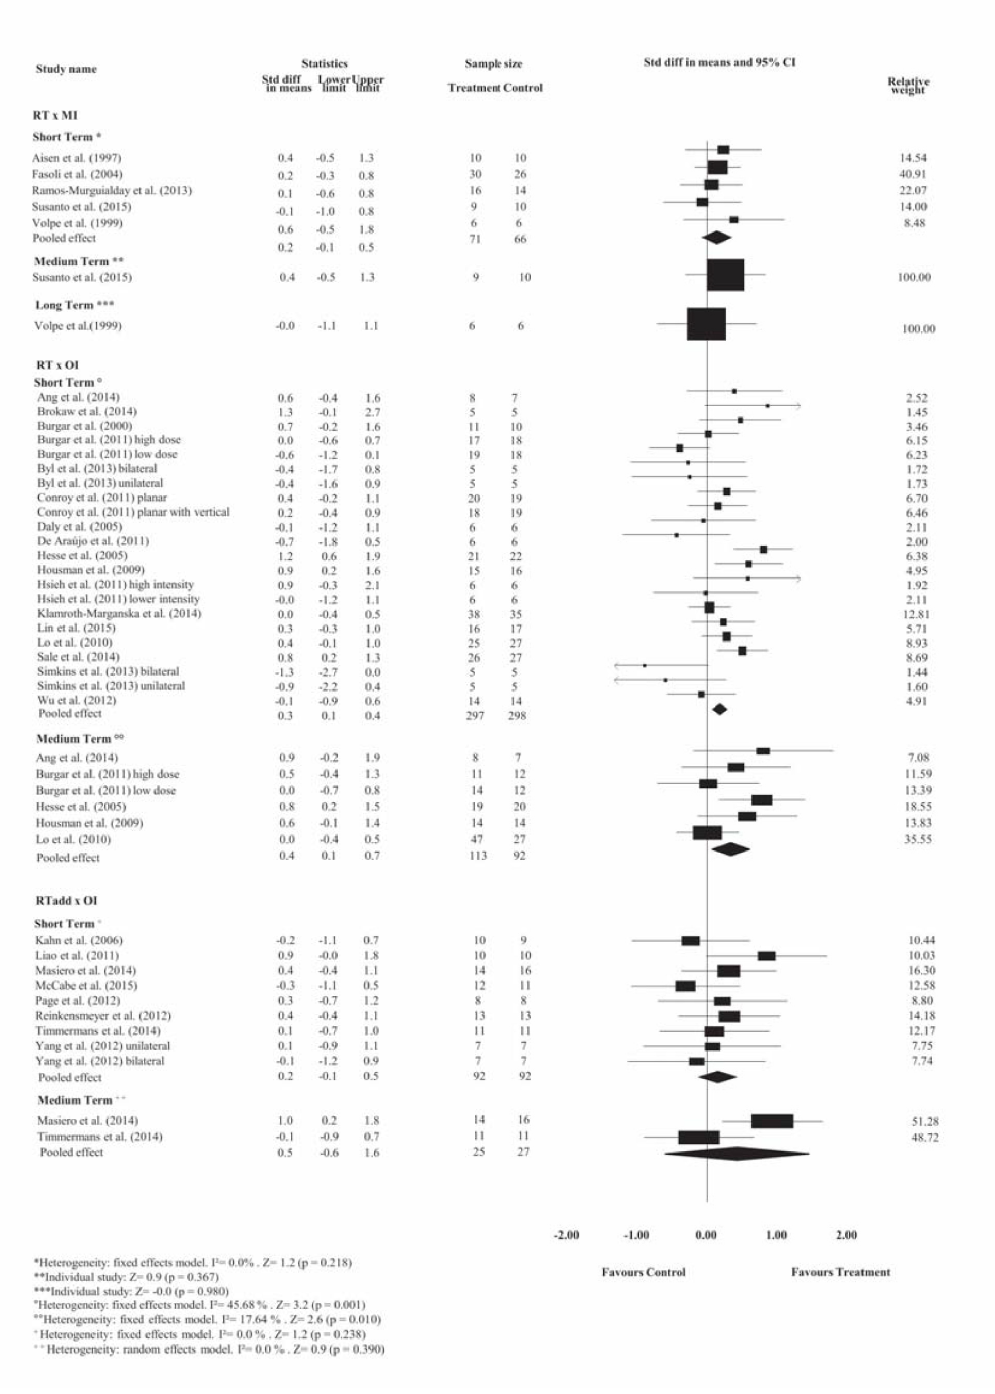
Fig 2. Standardized mean difference (95% CI) comparing RT or additional effect of RT versus MI or OI for motor control of people with limited upper limb function. RT = Robot-assisted therapy; RT add = additional effect of Robot-assisted therapy; OI = other intervention; MI = minimal